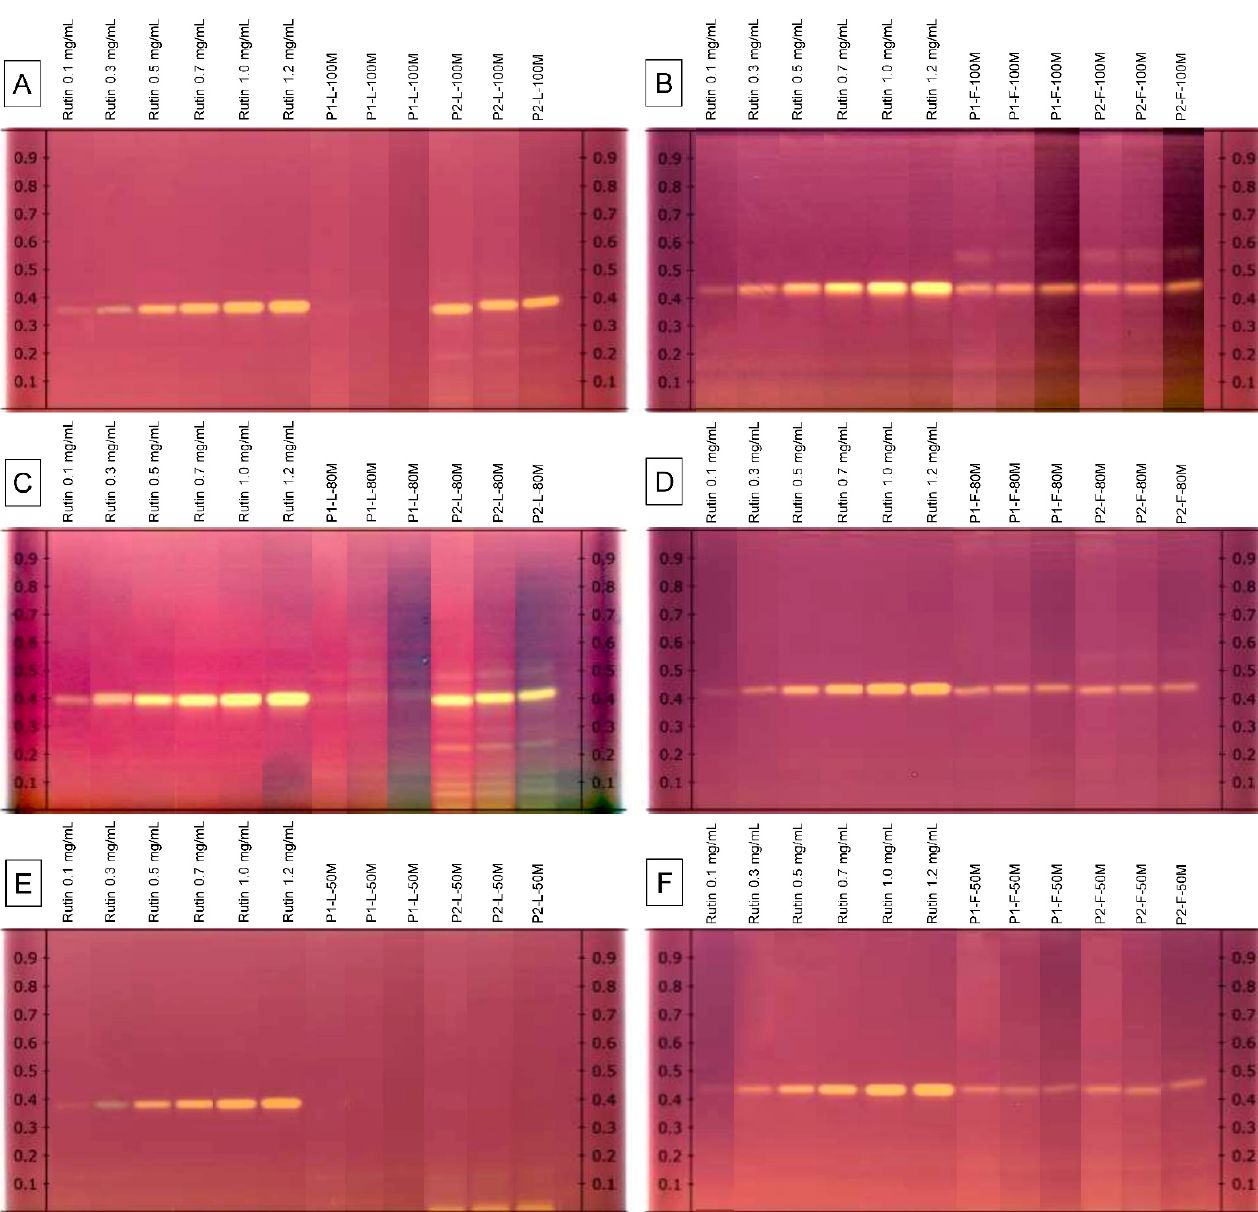
Figure 3. HPTLC chromatogram of methanolic extracts from Verbesina sphaerocephala under visible light in the transmittance mode after derivatization with DPPH • radical solution. ( A ) Leaf tissue from Populations 1 and 2 extracted with 100% methanol. ( B ) Flower tissue from Populations 1 and 2 extracted with 100% methanol. ( C ) Leaf tissue from Populations 1 and 2 extracted with 80% methanol. ( D ) Flower tissue from Populations 1 and 2 extracted with 80% methanol. ( E ) Leaf tissue from Populations 1 and 2 extracted with 50% methanol. ( F ) Flower tissue from Populations 1 and 2 extracted with 50% methanol.